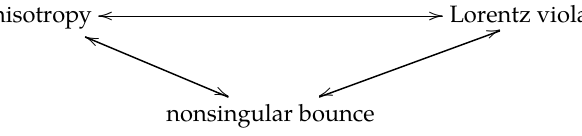
Figure 1. Connections of anisotropy, nonsingular bounce, and Lorentz